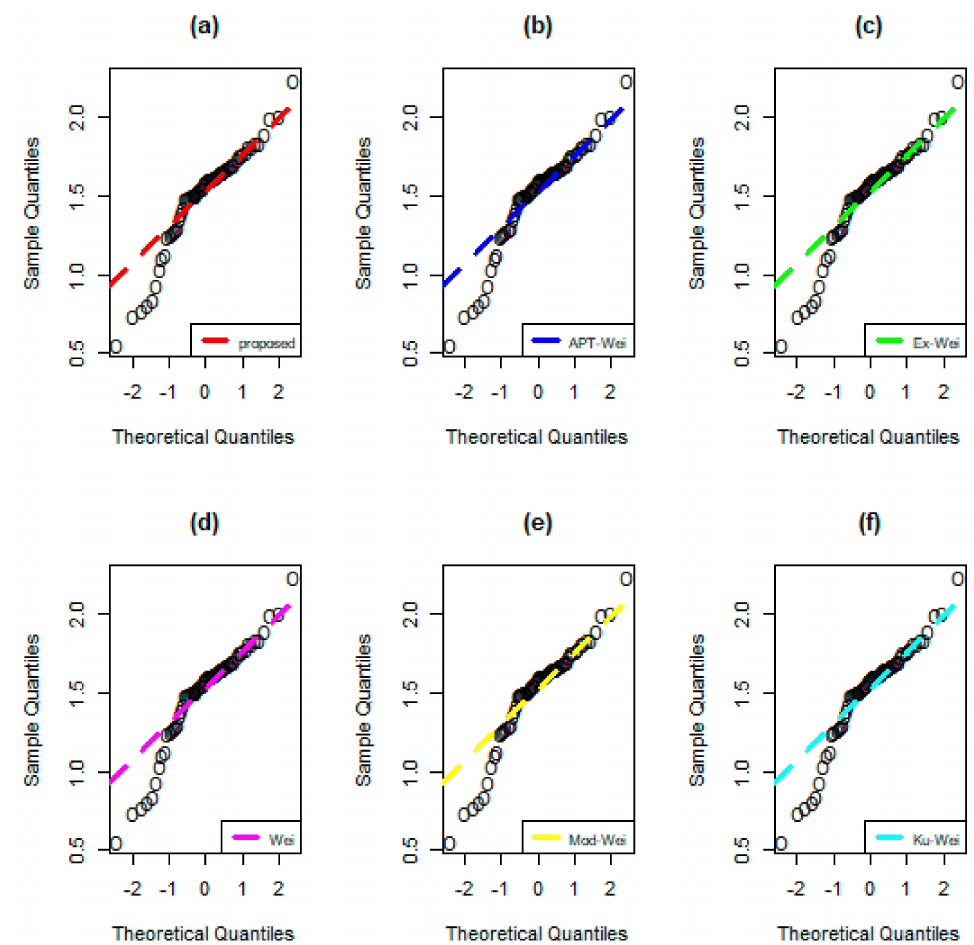
Figure 14. Q-Q (quantile–quantile) plots of ( a ) NMEPA-Wei, ( b ) APT-Wei, ( c ) Ex-Wei, ( d ) Wei, ( e ) Mod-Wei, and ( f ) Ku-Wei distributions for Data